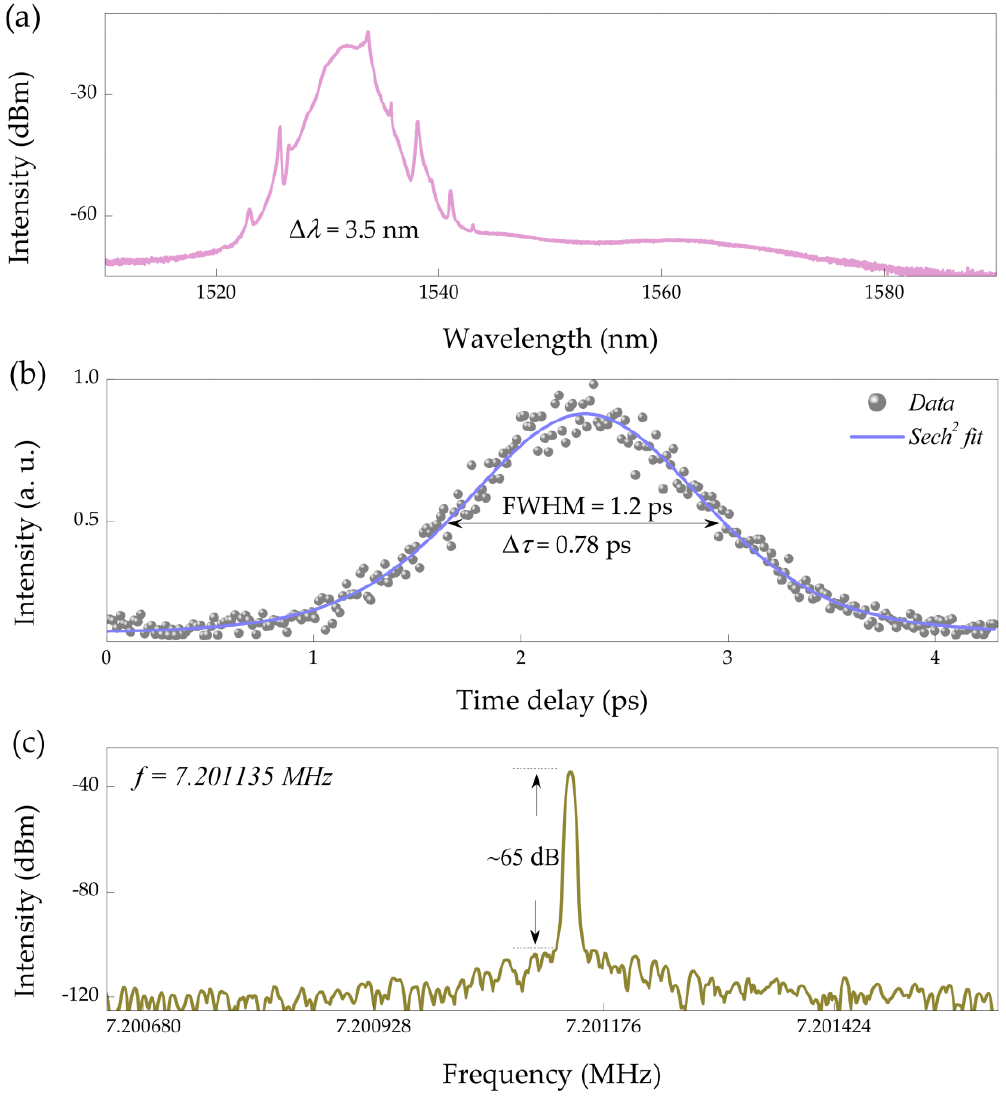
Figure 6. Single-wavelength conventional soliton. ( a ) Optical spectrum at 1532 nm, ( b ) autocorrelation trace, and ( c ) corresponding fundamental radio-frequency spectrum.